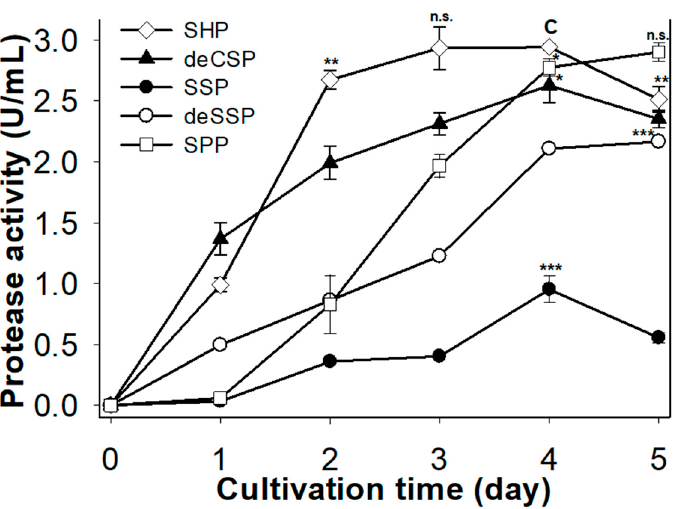
Figure 1. Screening of fishery processing byproducts as the C/N source for protease production in Paenibacillus sp. TKU047. All points on the graph indicate the mean of each experiment (with n = 3) and standard deviation (error bar). The letters n.s., *, **, and *** indicate not significantly different or significantly different at p < 0.05, p < 0.01, or p < 0.001, respectively, in comparison with the control group (C) based on one-way ANOVA analysis. The data point of SHP at day 4 was used to denote the control group.